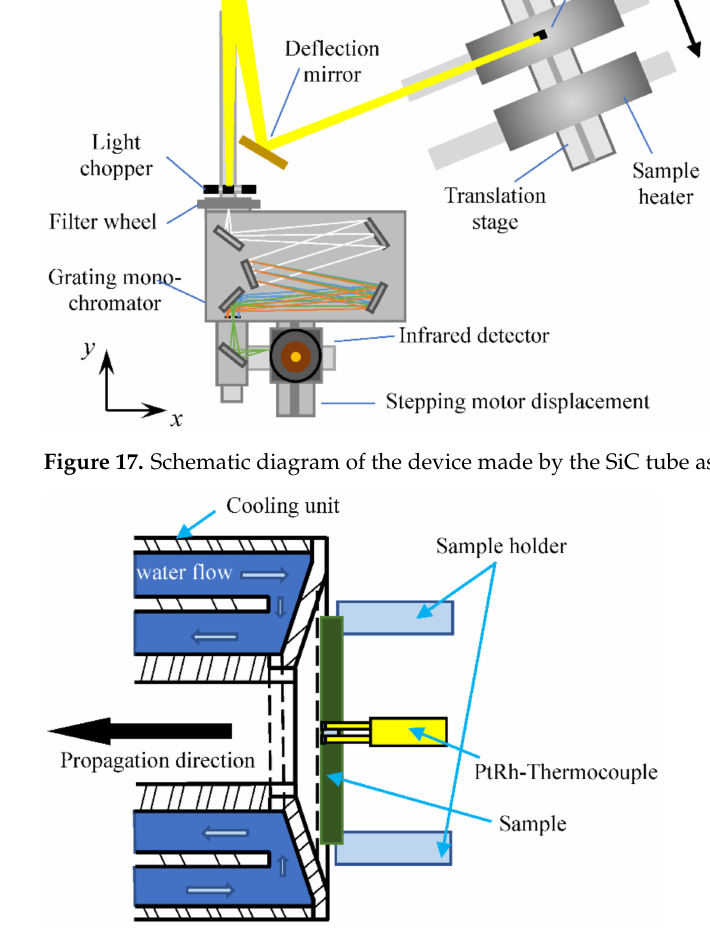
Figure 18. Schematic diagram of sample installation when the sample was heated by the SiC tube